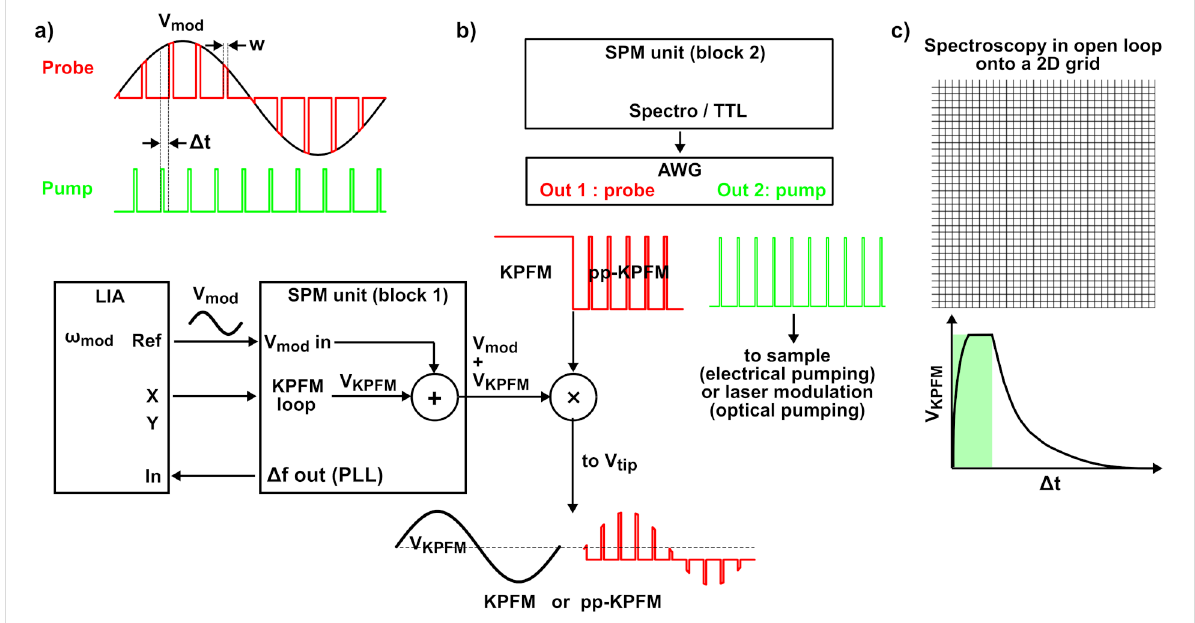
Figure 1: (a) Principle of pump–probe KPFM (pp-KPFM). In conventional KPFM, a sinusoidal ac voltage V mod of frequency ω mod is applied to the tip, and the electrostatic forces are detected with a lock-in amplifier (LIA). In pp-KPFM, the tip voltage consists of pulses with the same sinusoidal enve- lope of ω mod , which is used by the LIA as the reference for the detection of the electrostatic forces. Consequently, the KPFM loop compensates only the tip–sample contact potential difference (CPD) that exists during the pulse of width w . The time-evolution of the CPD is monitored by recording the voltage at the output of the KPFM loop ( V KPFM ) as a function of the delay Δ t between the probe and pump pulses. (b) Scheme (top middle and bottom left-middle) of the signal processing by the scanning probe microscope (SPM) controller, the LIA and the arbitrary waveform generator (AWG). The electrostatic forces are detected by feeding the frequency-shift signal ( Δ f ) from the SPM phase-lock loop to the LIA input (KPFM operated in frequen- cy-modulation mode). Using the SPM unit (block 1), the reference bias modulation voltage ( V mod , ω mod ) is added to the compensation voltage gener- ated by the KPFM feedback loop. The sum is multiplied by the output of the first channel of the AWG dedicated to the probe signal, which delivers a continuous voltage level or continuous voltage pulses. The setup can be automatically switched from standard KPFM to pp-KPFM configuration. The second AWG channel generates the pulses that are used for electrical pumping of the sample or for optical pumping by digitally modulating a laser unit, which is used for sample illumination. Transistor–transistor logic (TTL) signals synchronized with the spectroscopic ramps are generated by the SPM unit to trigger the generation of sequences of probe and pump pulses with predefined delays. (c) Spectroscopic curves of the KPFM potential V KPFM as a function of the pump–probe delay time Δ t can be acquired at selected locations or on a predefined 2D grid (data-cube